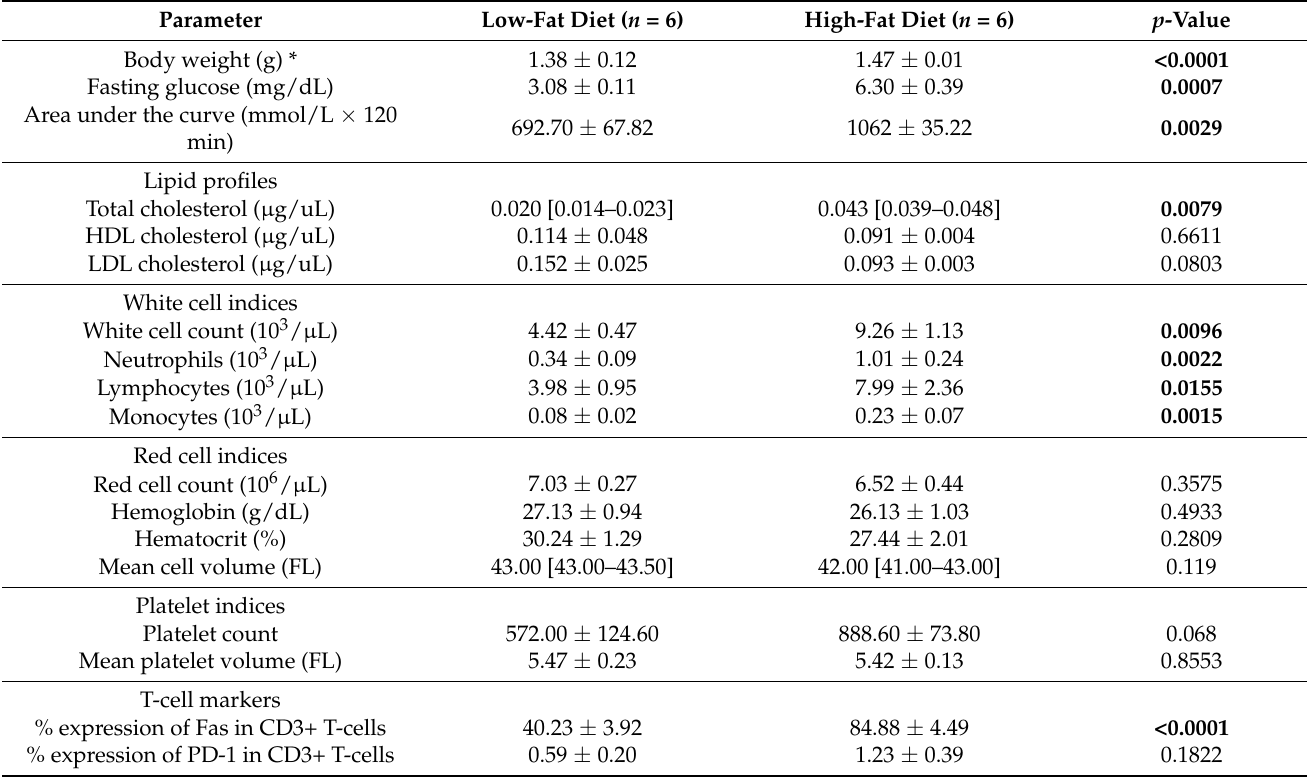
Table 1. Characteristics of mice after 8 weeks of feeding on a low-fat diet versus a high-fat diet ( n = 6/group).